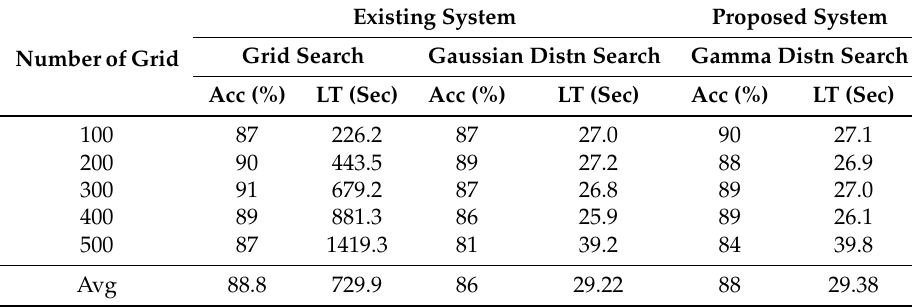
Table 7. Comparison of grid search, Gaussian distribution search, and Gamma distribution search, applying 10 counts of optimization and 50 epochs. LT, learning